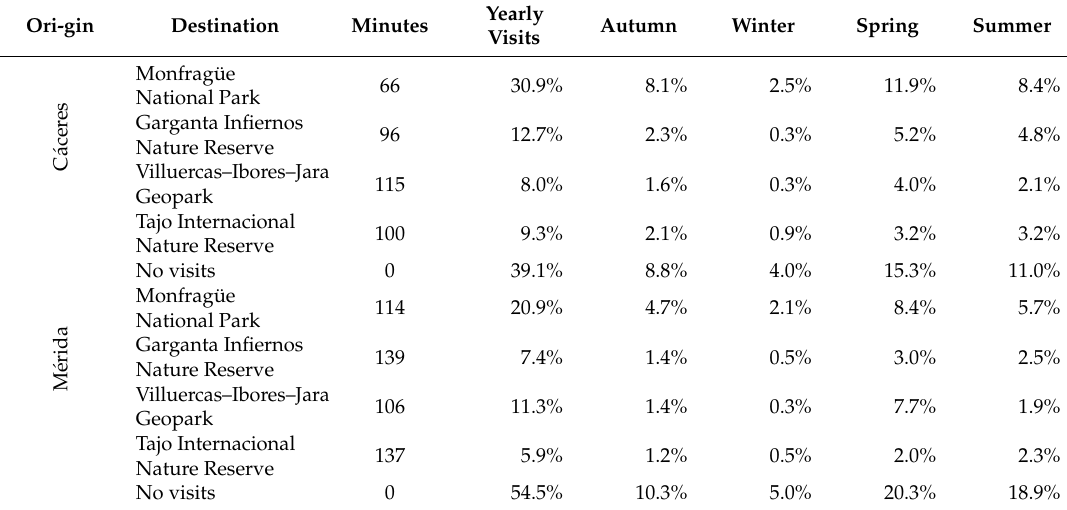
Table 4. Duration of travel and seasonal visits to protected natural